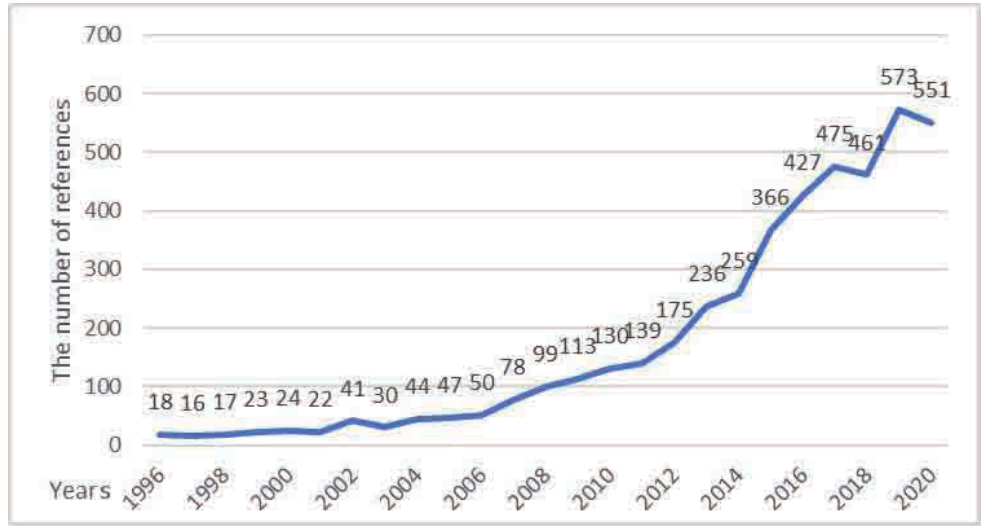
Figure 2. Trends in the number of